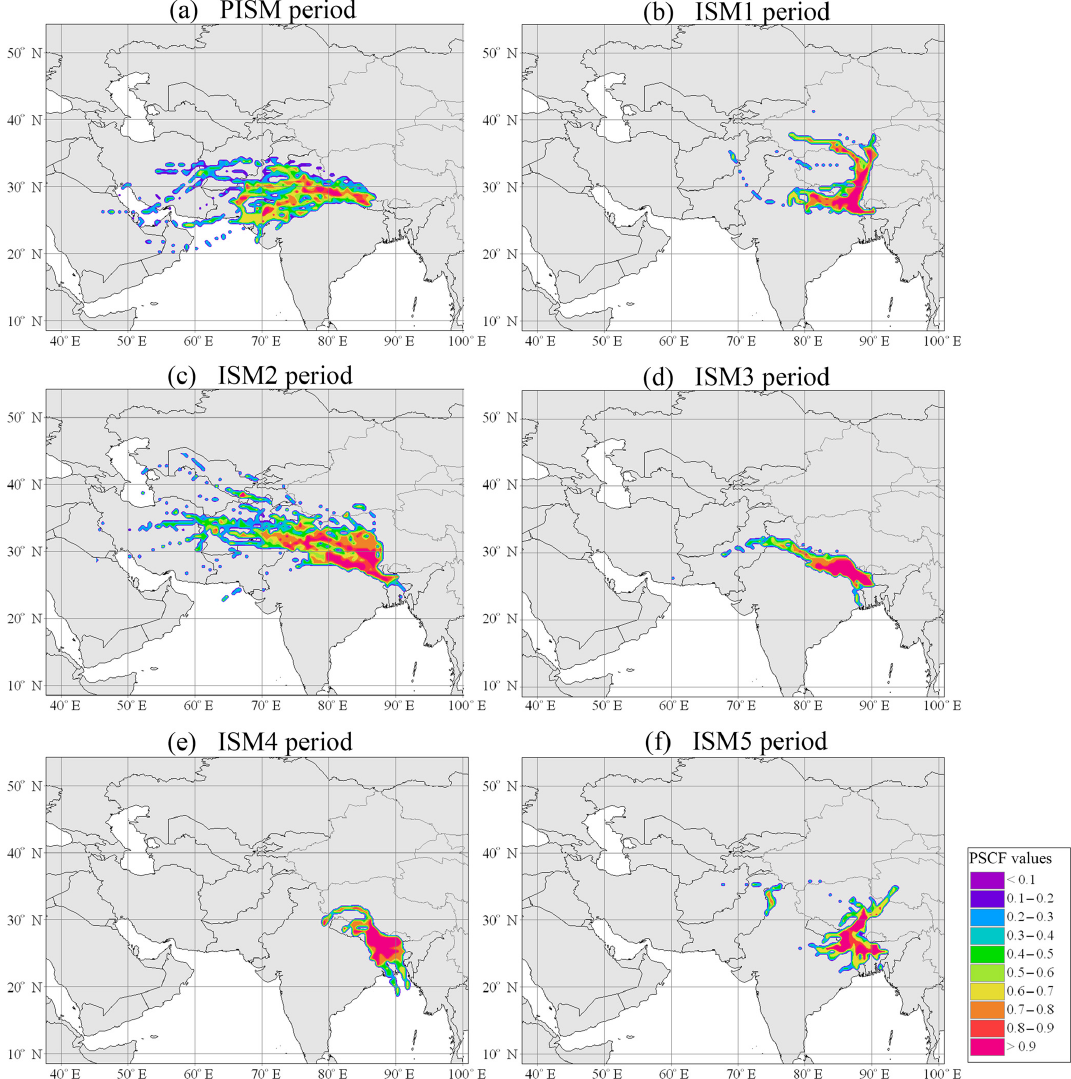
Figure 6. Potential source regions and pathways of GEM using the potential source contribution function (PSCF) method before and during the Indian summer monsoon (ISM). PSCF values represent the probability that a grid cell is a source of